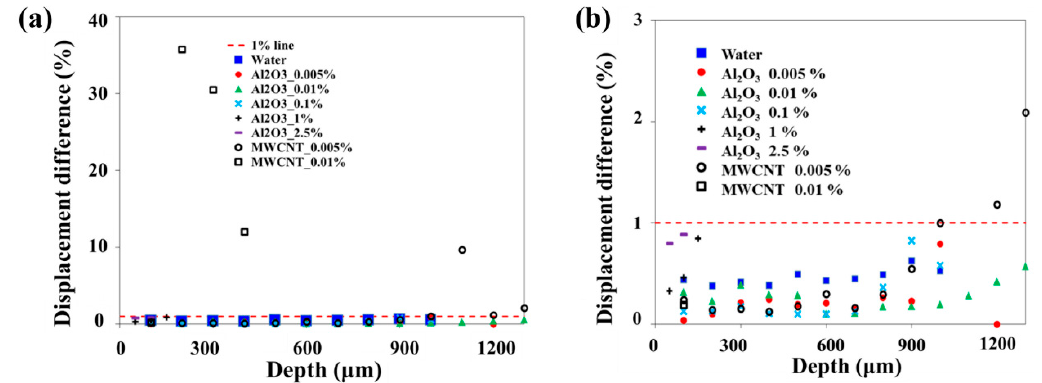
Figure 4. ( a ) Displacement difference at different focal plane depths. ( b ) The magnified graph of the displacement difference of less than 3% and the red dotted line represents a 1% difference.